Question: Summarize what this figure shows in one sentence.
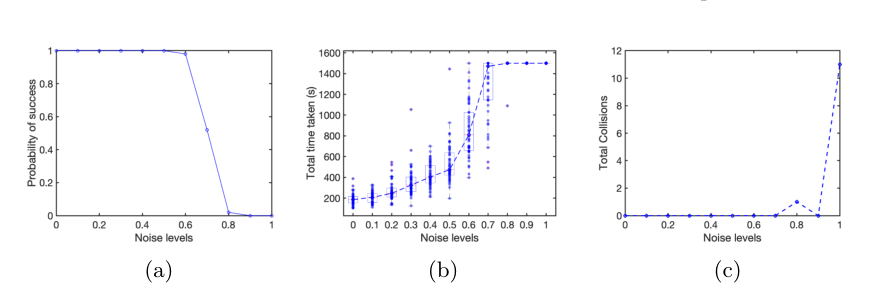
Answer: For p = 5 (a) probability of success as a function of noise levels (b) time taken for task completion (c) number of rsafe g violations across all simulations.